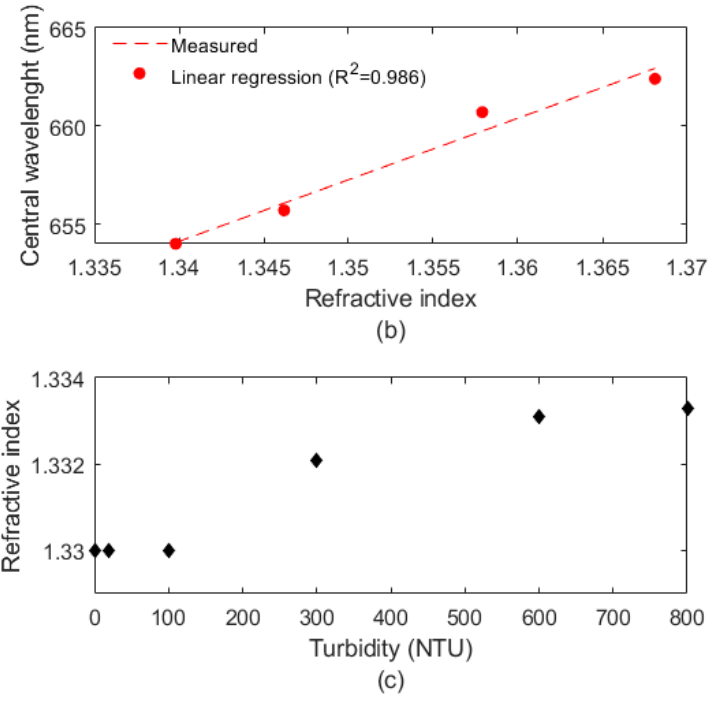
Figure 4. ( a ) Transmitted spectra, ( b ) linear regression., ( c ) RI for turbidity samples.